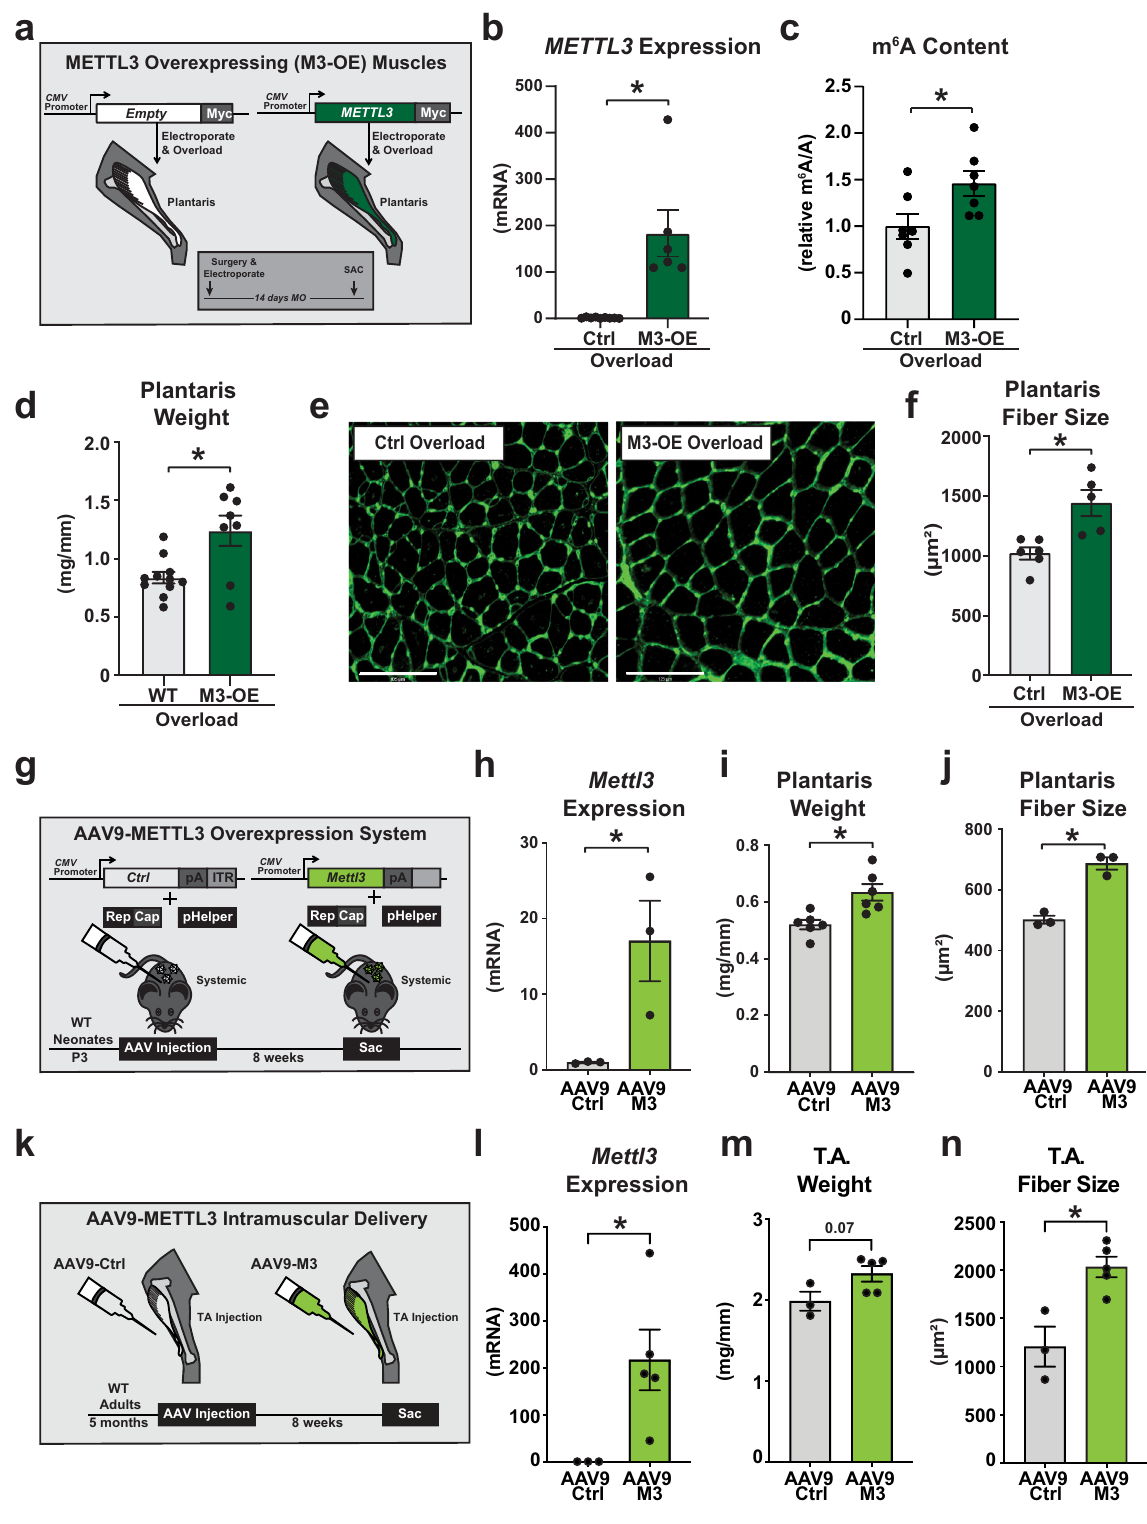
of the myostatin pathway. To demonstrate the causal rela- dependent regulation of muscle mass we administered ACE- as this protein is a predominant ligand for these receptors in skeletal muscle) (Fig. 6e). Co-administration of the myostatin inhibitor fully rescued the impaired hypertrophic growth